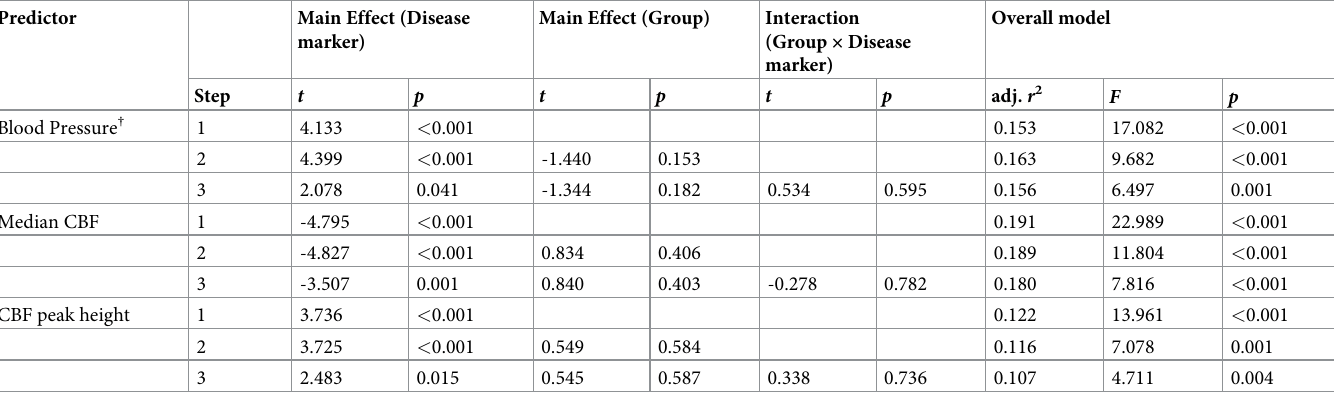
Table 2. Single variable models (hierarchical linear regression)–Brain Tissue Volume.